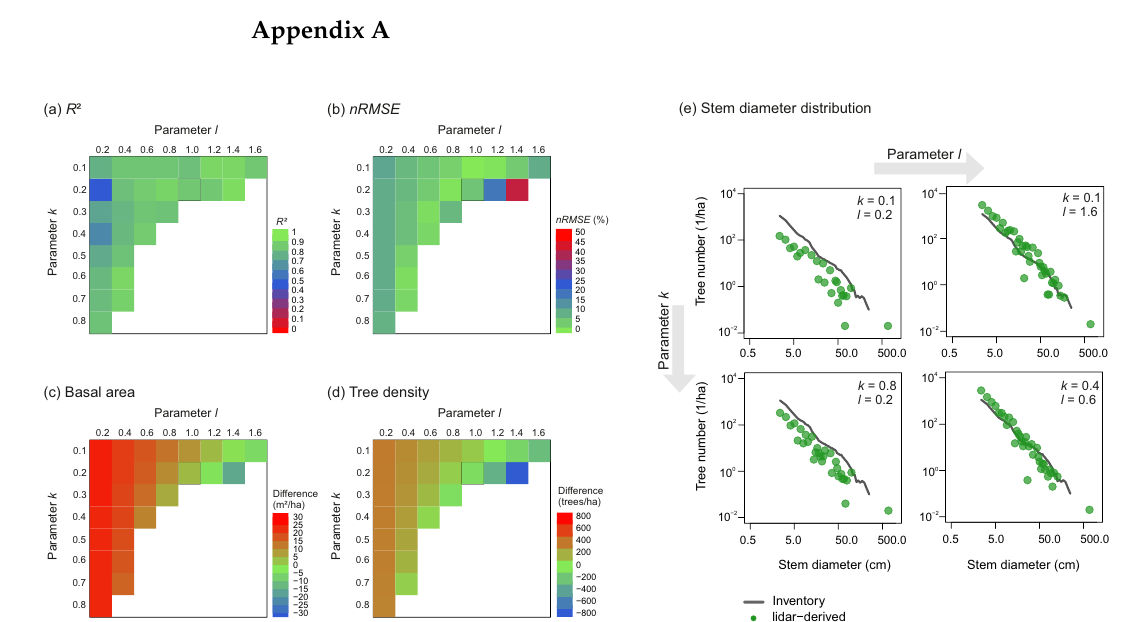
Figure A1. Sensitivity of the parameters k and l on the accuracy of estimating the stem diameter distribution (50-ha scale). ( a ) The R 2 values, ( b ) the nRMSE (%) values, ( c ) the difference of the field-derived basal area (30.1 m 2 /ha) to lidar-derived estimates, and ( d ) the difference of field-observed tree density (447.3 trees per ha) to lidar-derived estimates are shown for different combinations of parameter values (default values are k = 0.2 and l = 1). The quality of the values is indicated by gradients from green (good quality) to blue and red (lower quality). White cells demonstrate that no solution was possible due to infinite values in the leaf area profile derived from lidar (using the respective parameter combination). ( e ) The estimated and observed stem diameter distributions compared for selected parameter combinations of k and l .